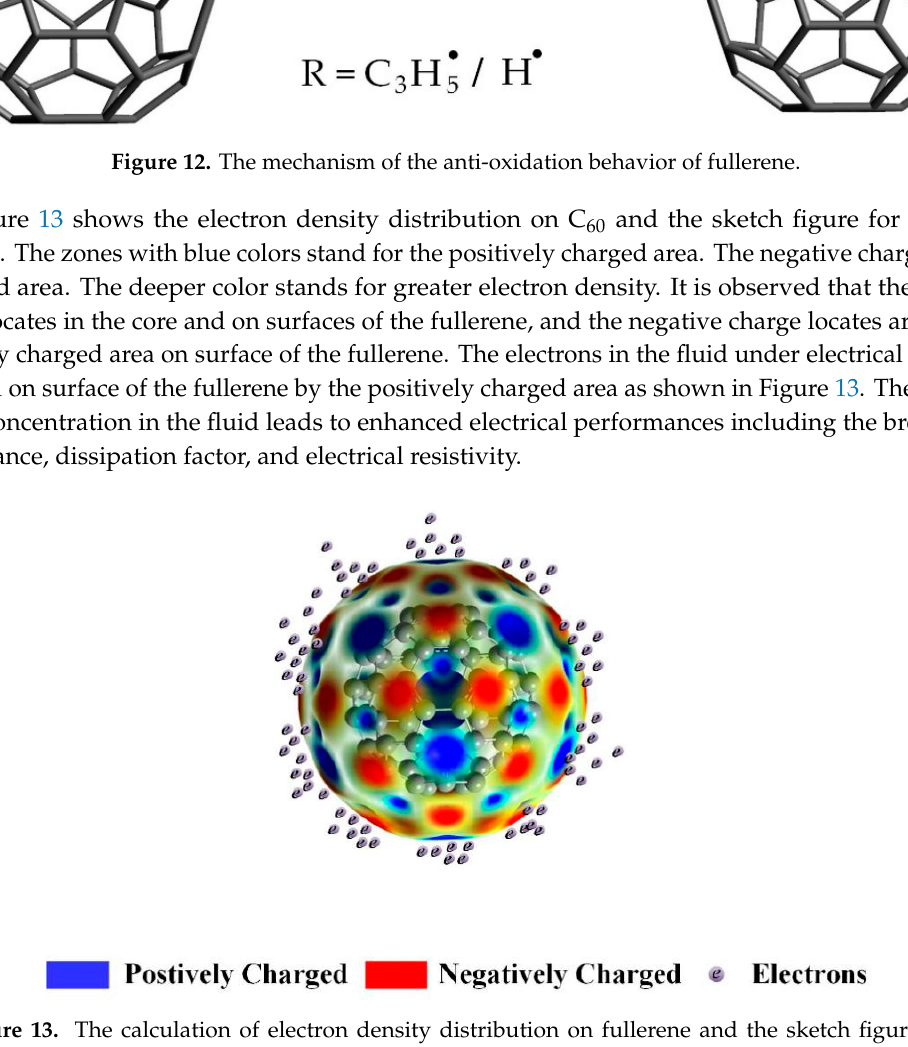
Figure 12. The mechanism of the anti-oxidation behavior of fullerene.